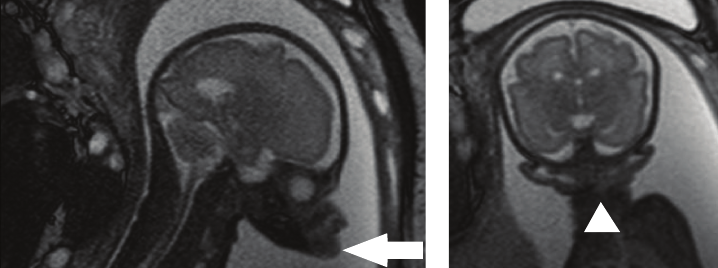
Figure 2: Magnetic resonance imaging demonstrated agnathia with low-set ventromedial displaced ear (arrowhead) and small opening of the mouth (arrow).